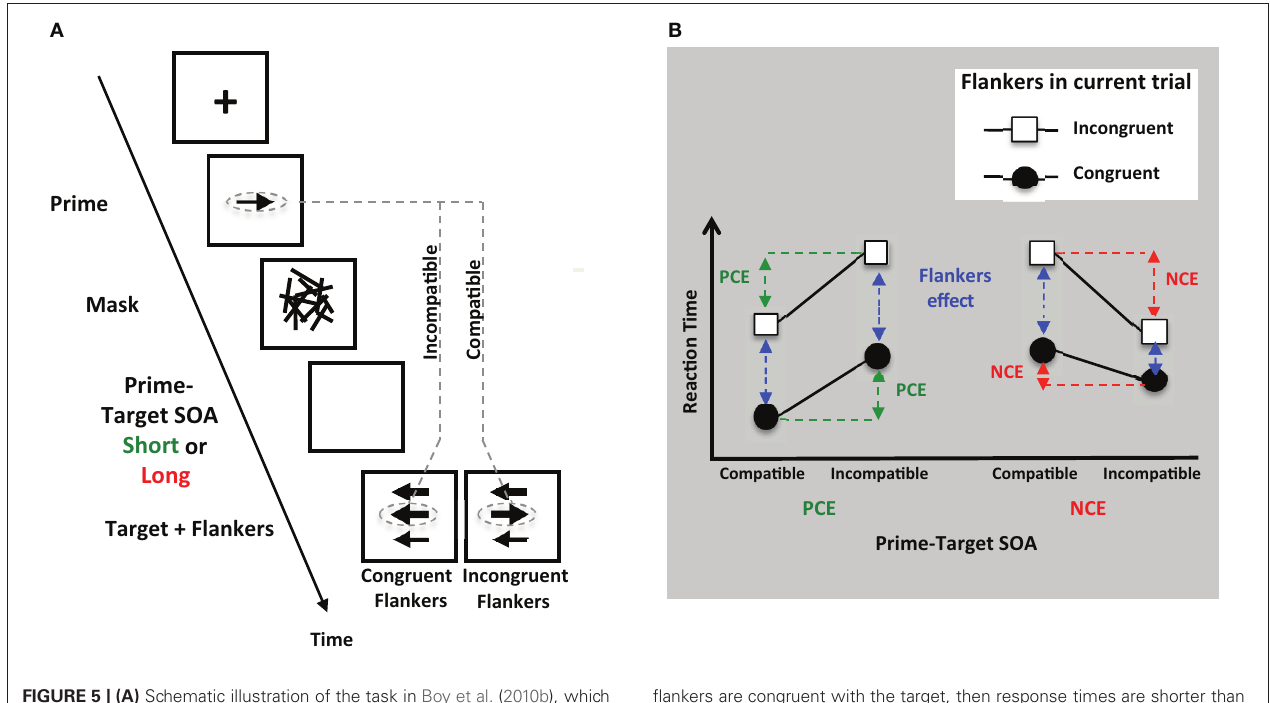
flankers are congruent with the target, then response times are shorter than if flankers are incongruent (the flanker interference effect; blue arrows in B ). 4-B. Results: for positive priming (PCE), the priming effect was additive with the effect of flanker interference. For the NCE, which measures subliminal inhibition, there was an interaction with flanker interference. This interaction did not occur for pre-stimulus control [data not shown here, see Boy et al.